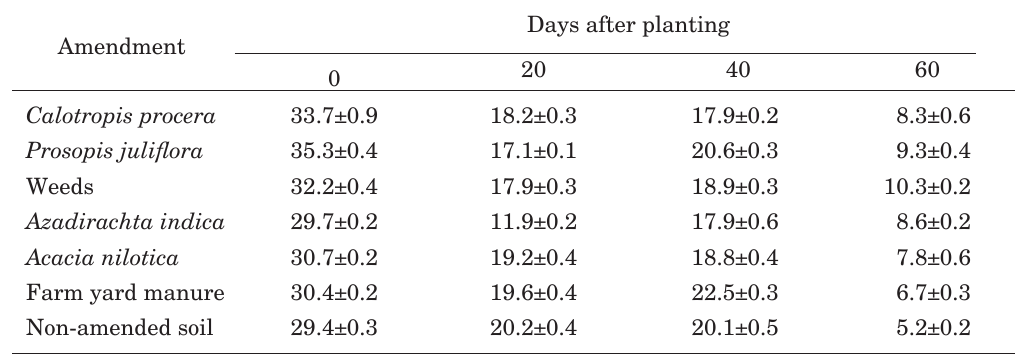
Table 2. Soil moisture content (mm) a in compost amended and unamended plots in a cowpea field during the 2001 crop